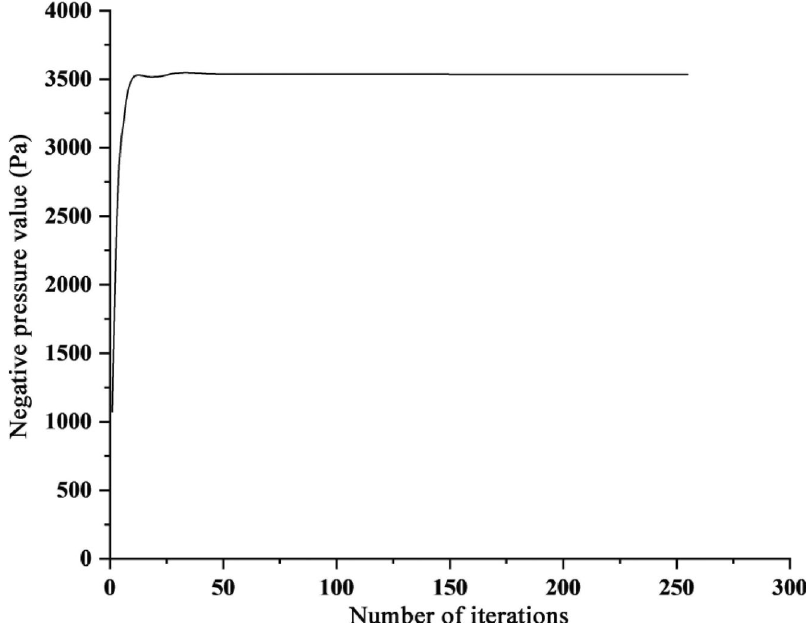
Figure 14. Negative pressure value of negative pressure